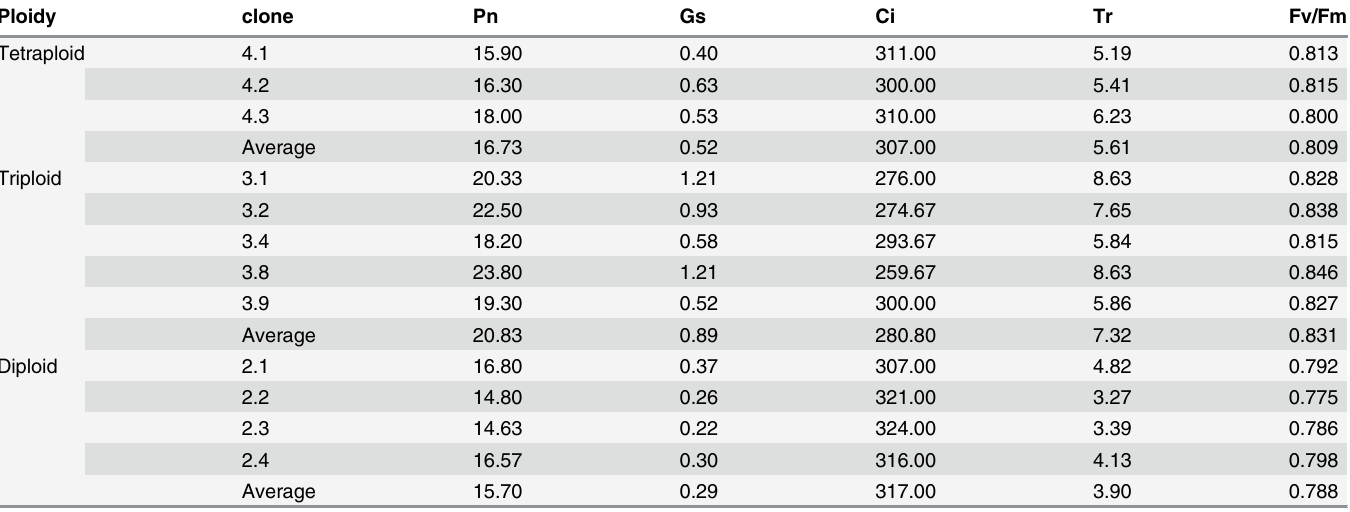
Table 6. Average photosynthetic and chlorophyll fluorescence traits of hybrid clones of different ploidies. Ploidy